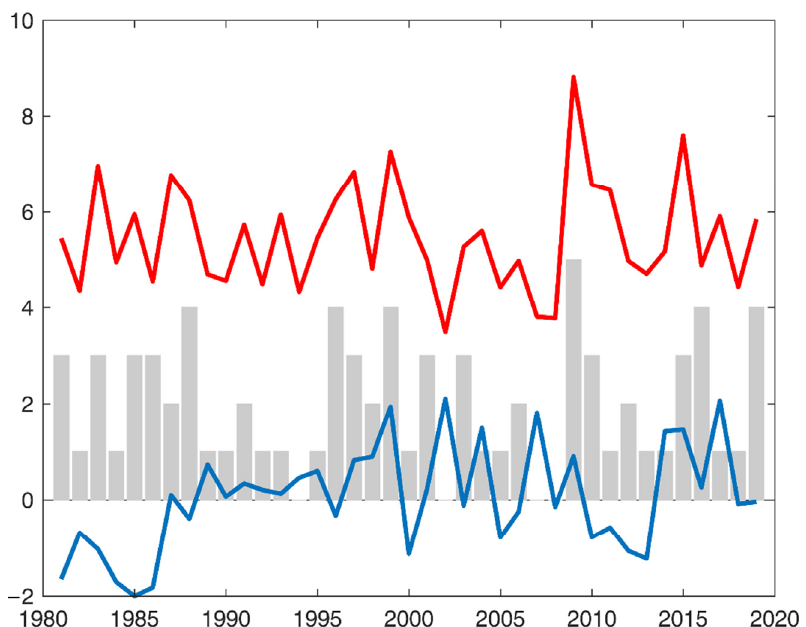
Figure 4. Frequency of ECSs (bar, unit: times / winter), mean winter temperature anomalies (blue line, unit: °C) and maximal temperature drops (red line, unit: °C) over the representative domain of 24th Olympic and Paralympic Winter Games (BJ2022).